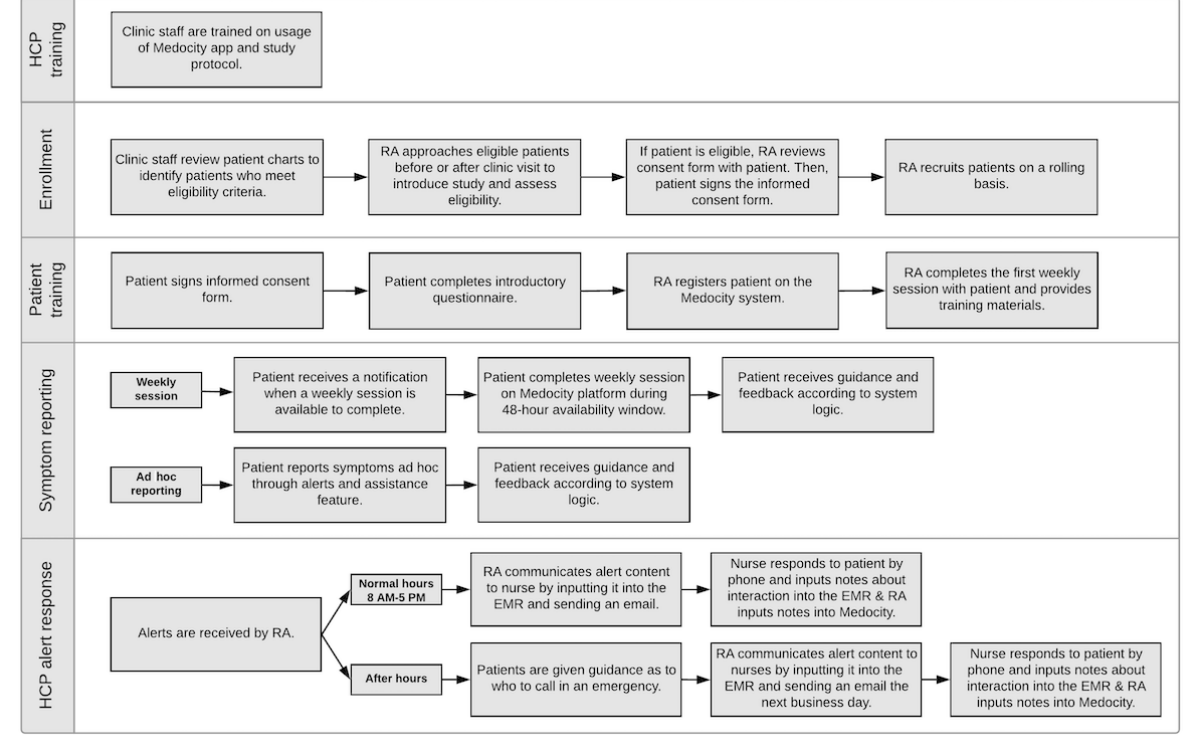
Operationalization of Implementation